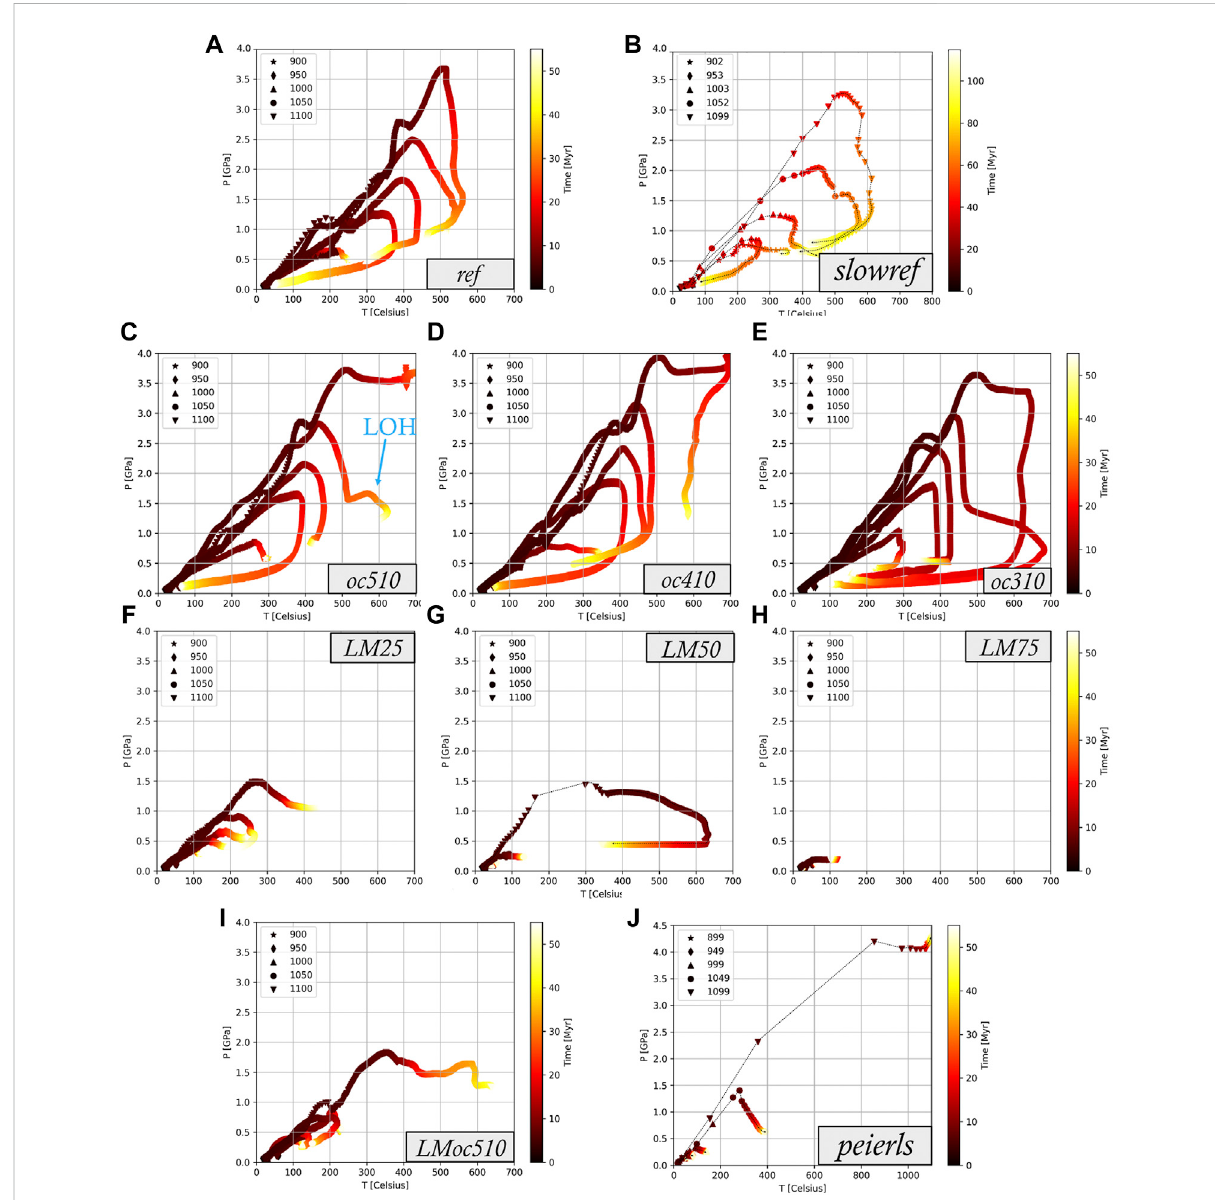
FIGURE 4 Pressure,Temperature,time(PTt)pathsofmodels (A) ref , (B) slowref , (C) oc510 , (D) oc410 , (E) oc310 , (F) LM25 , (G) LM50 , (H) LM75 , (I) LMoc510 , and (J) peierls (Table2).Thepathsfollow fi vemarkersinitiallylocatedatpositionsx=900 – 1,100 kmburied > 2 kmdeepinthecontinentaluppercrust (initialpositioninlegend).Model oc510